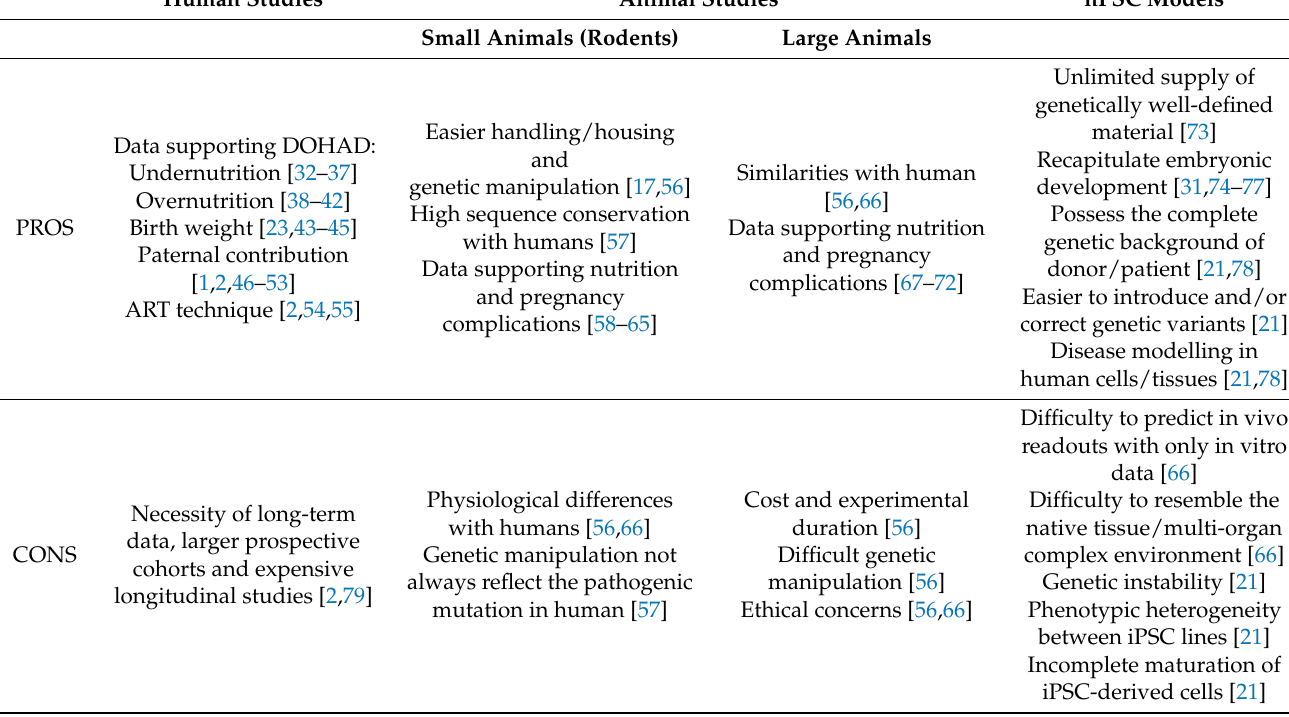
Table 1. Advantages and disadvantages of the models to study DOHaD and CVD risks. Human Studies Animal Studies hPSC